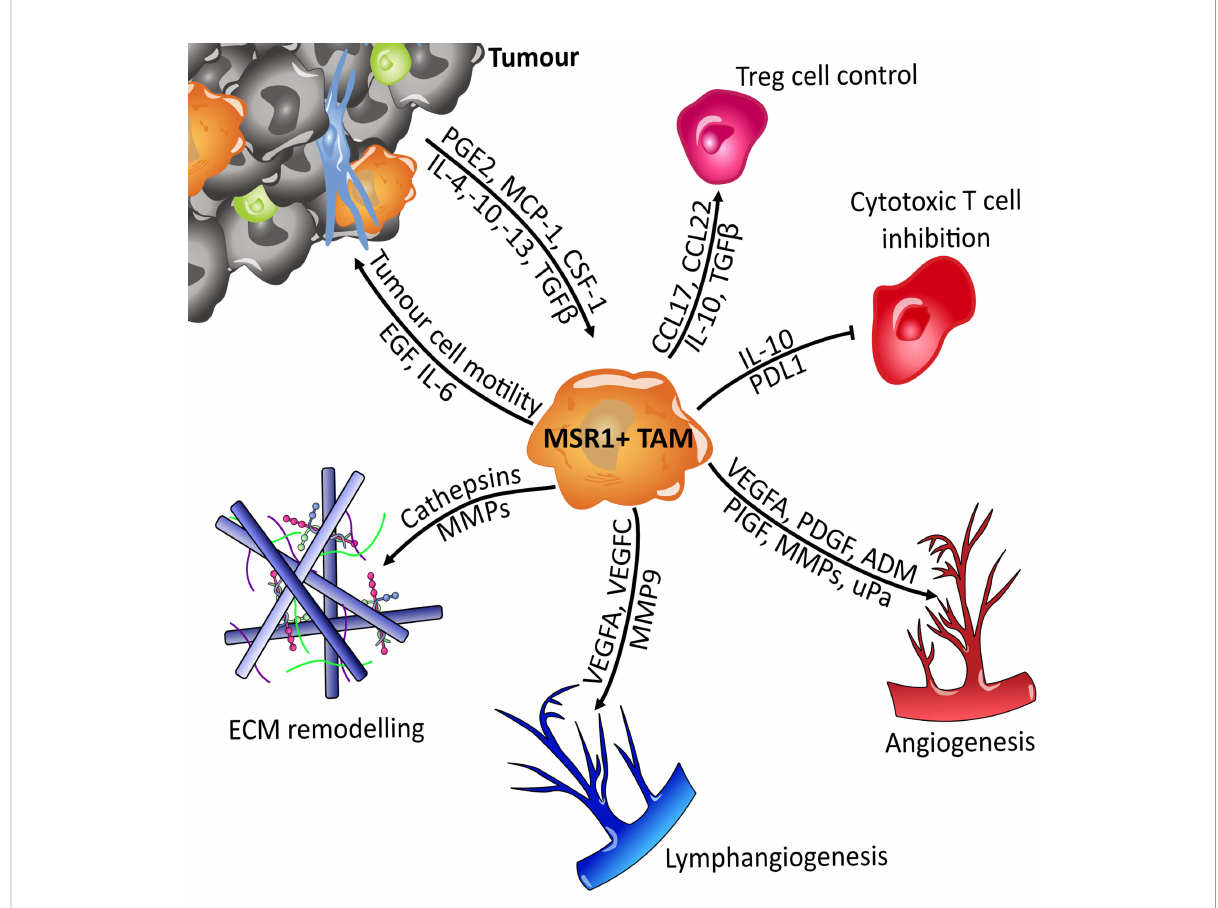
FIGURE 9 Overview of MSR1-positive TAMs signalling. Macrophages become polarised towards the M2-like tumour-associated macrophage (TAM) phenotype by tumour derived factors such as IL-4 and CSF-1. Once polarised they then support tumour expansion and metastasis by secreting factors that in fl uence several of the hallmarks of cancer. They suppress the immune system by regulating the function of T reg (Regulatory T cells) and cytotoxic T cells (CD8+). Metastasis and growth are facilitated through breakdown of the extracellular matrix (ECM), the induction of angiogenesis and lymphangiogenesis, and directly through cytokine mediated in fl uence of tumour cell motility. Adrenomedullin (ADM); colony stimulating factor 1 (CSF-1); epidermal growth factor (EGF); interleukin (IL); matrix metalloproteinases (MMPs); monocyte chemoattractant protein-1 (MCP-1); placental growth factor (PlGF); platelet-derived growth factor (PDGF); programmed death-ligand 1 (PDL1); prostaglandin E1 (PGE-1); transforming growth factor beta (TGFb); urokinase plasminogen activator (uPa); vascular endothelial growth factor A